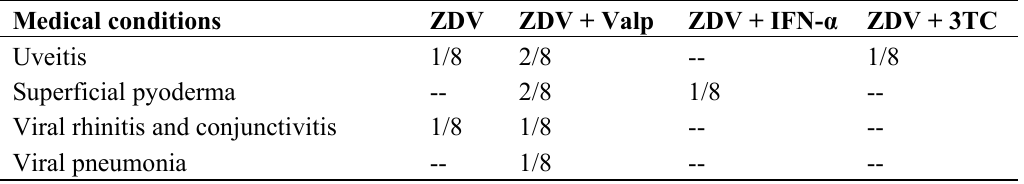
Table 1. Clinical signs noted in the study population throughout the year of